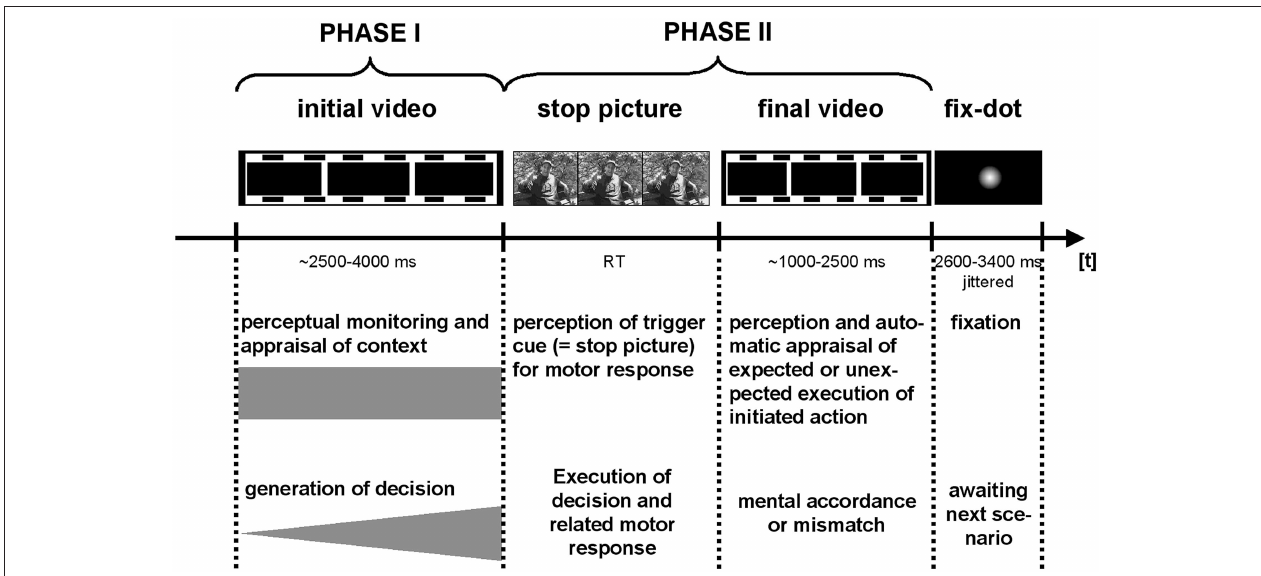
FIGURE 1 | Trials elements and timing: Functional imaging data were separately modeled for PHASE I and PHASE II of the interaction scenarios, and the fixation period between